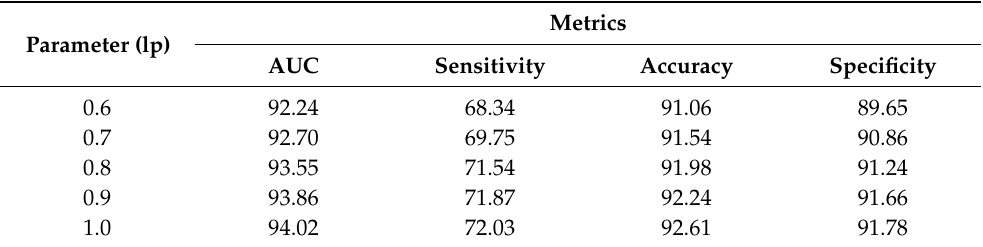
Table 5. Effects of different lp parameter values on the performance of our semi-supervised model on the ISIC 2018